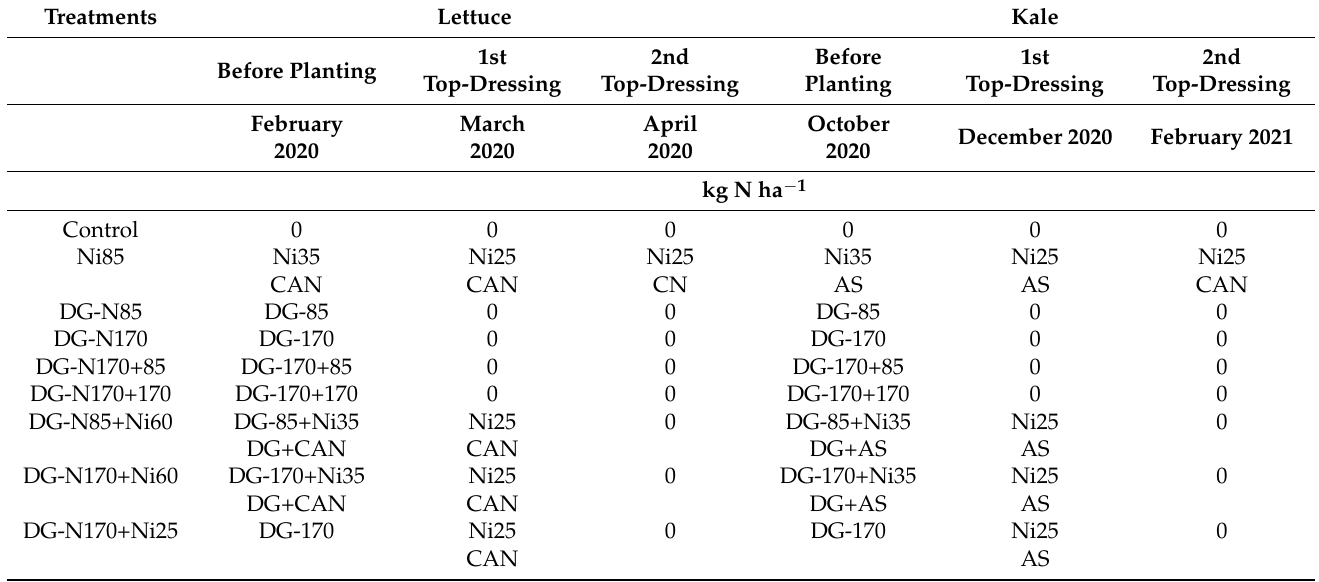
Table 1. Treatments and fertilisation done during the field experiments with lettuce and